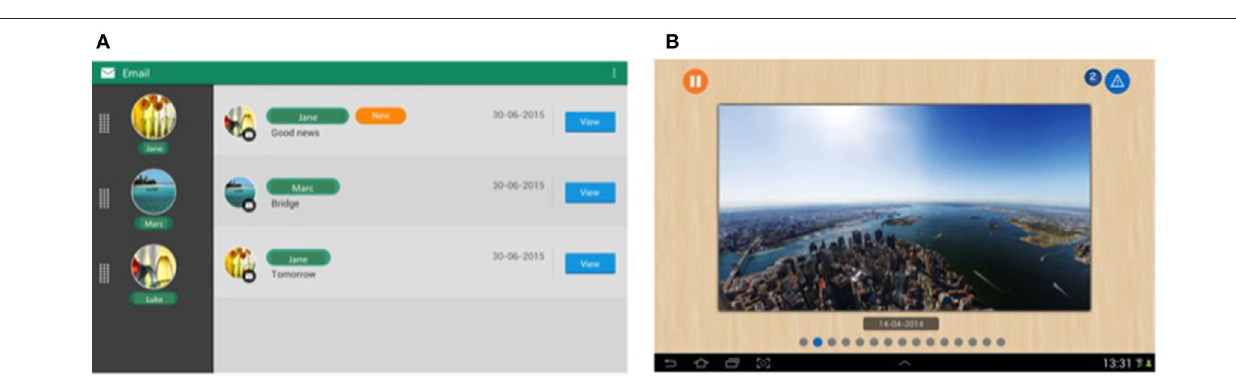
FIGURE 2 | Snapshots of interfaces displayed on the tablets. (A) Inbox interface of our simplified mailing application; (B) Digital picture frame (from Dupuy et al.,